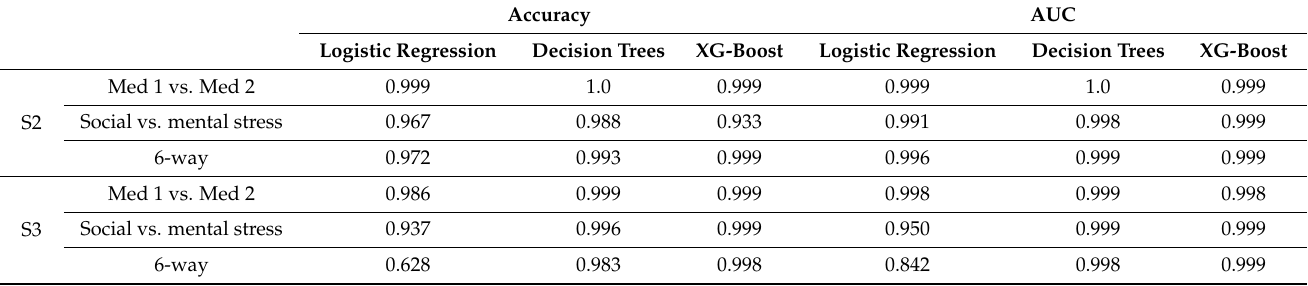
Table 3. Classification accuracy using all features.